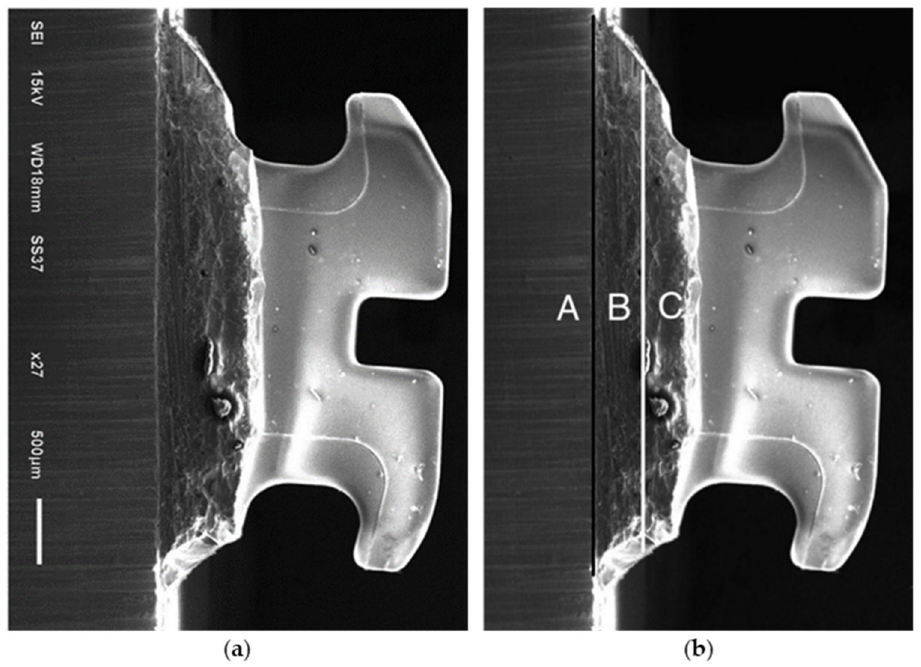
Figure 4. ( a ) Cross-sectional SEM image of the glazed monolithic zirconia attached to ceramic bracket (original magnification 27 × , bar represents 500 µ m); ( b ) A, zirconia layer; B, adhesive layer; C, bracket base layer; black line, zirconia–adhesive interface; white line, bracket base–adhesive